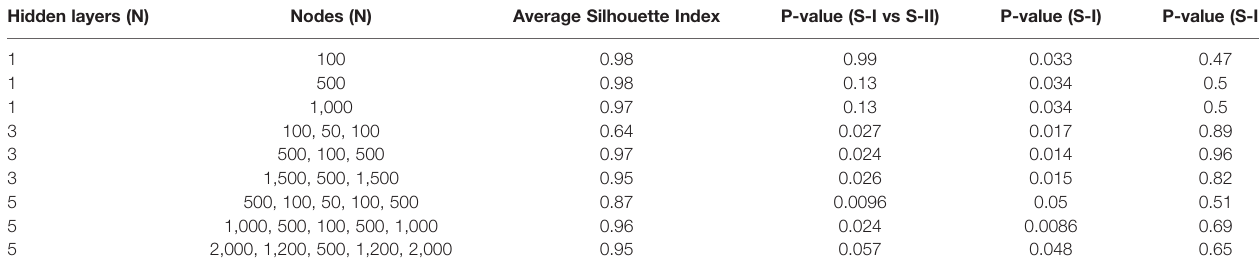
TABLE 3 | Performance of AE with different hidden layers and nodes in discovery set. Hidden layers